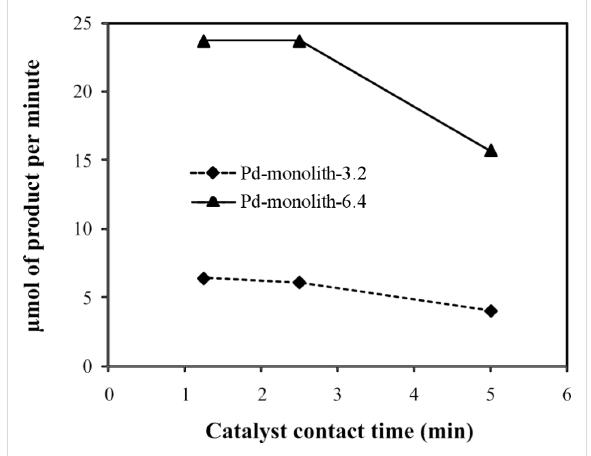
Figure 3: Reactivity of the Pd-monolith-3.2 and Pd-monolith-6.4 for the Suzuki–Miyaura reaction between bromobenzene (0.1 M) and phenyl-